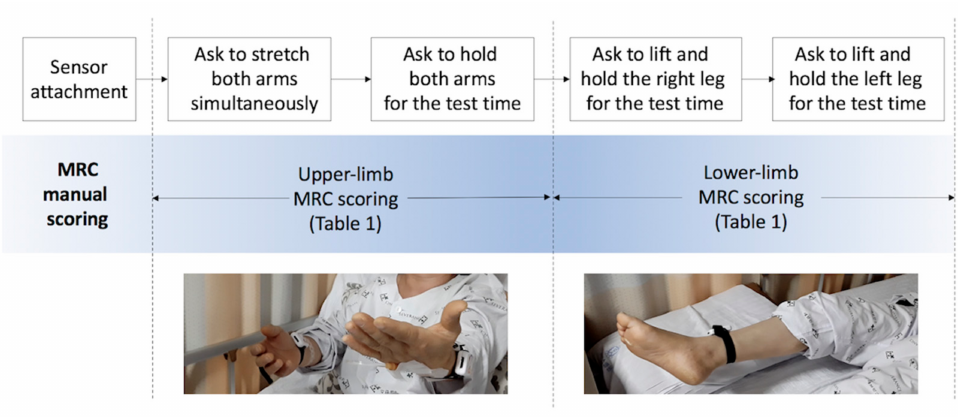
Figure 1. Protocol of proximal-weakness assessment. MRC, Medical Research